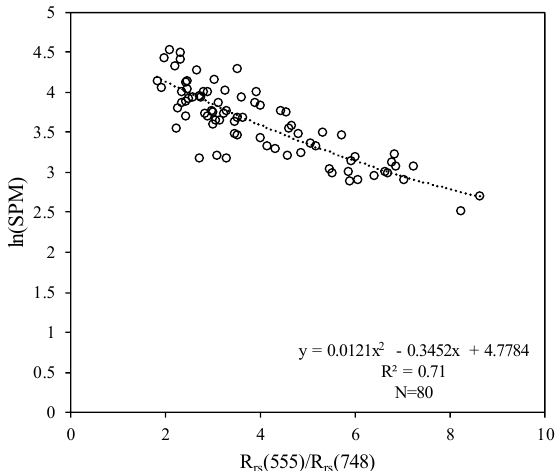
Figure 6. Model of SPM concentration and R rs (555) / R rs (748) based on measured data.